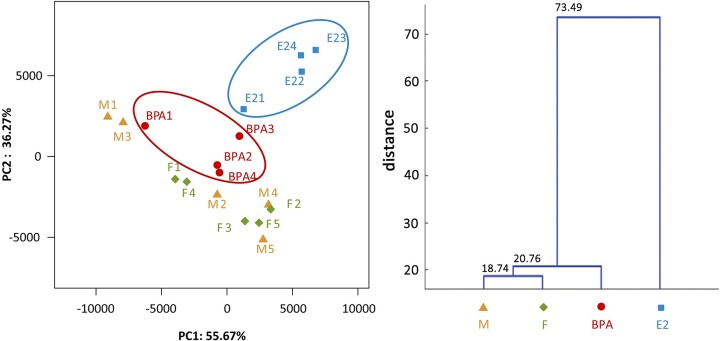
Overall structural comparison of intestinal microbiota in Groups M, F, BPA and E2.a) Principal component analysis scores plot. b) Clustering analysis of intestinal microbiota. The triangle, rhombus, roundness and square represented samples of Groups M, F, BPA and E2, respectively.